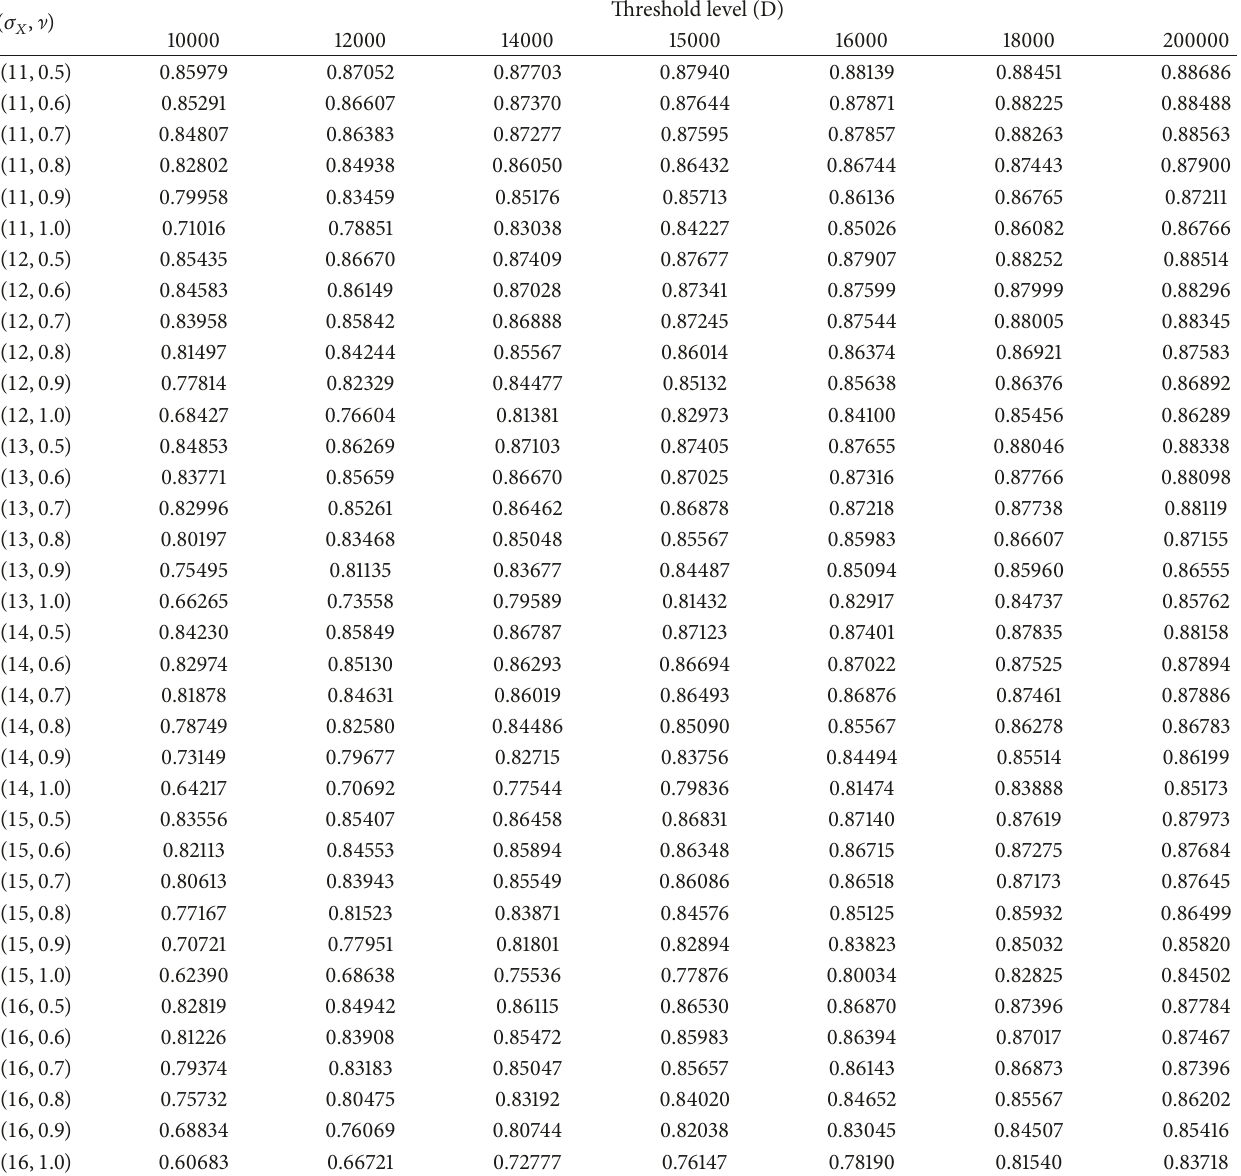
Table 4: The zero-coupon CAT bond prices with trading time 𝑡 to expiry 𝑇